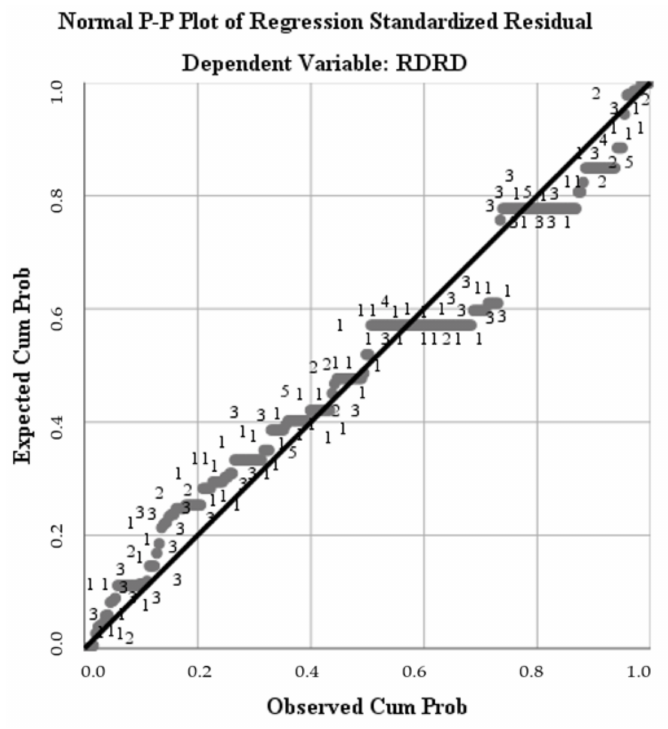
Figure 2. P-P Plot distribution for